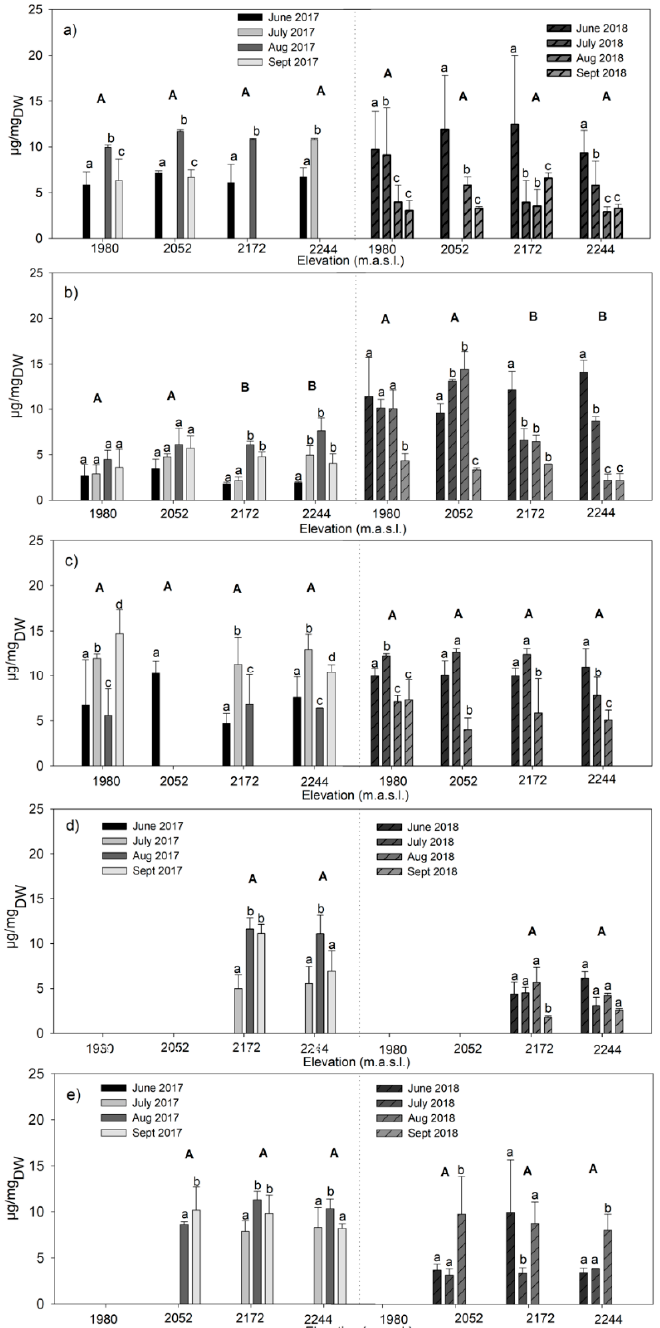
Figure 1. Seasonal changes in Chl TOTAL in ( a ) Erysimum penyalarense , ( b ) Festuca curvifolia , ( c ) Senecio carpetanus , ( d ) Hieracium vahlii , and ( e ) Jurinea humilis throughout the elevational gradient. Data from two consecutive years of study (2017, 2018). Different lower-case letters indicate significant differences ( p < 0.05) between dates at a given elevation, and upper-case letters indicate significant differences between elevations ( p < 0.05).